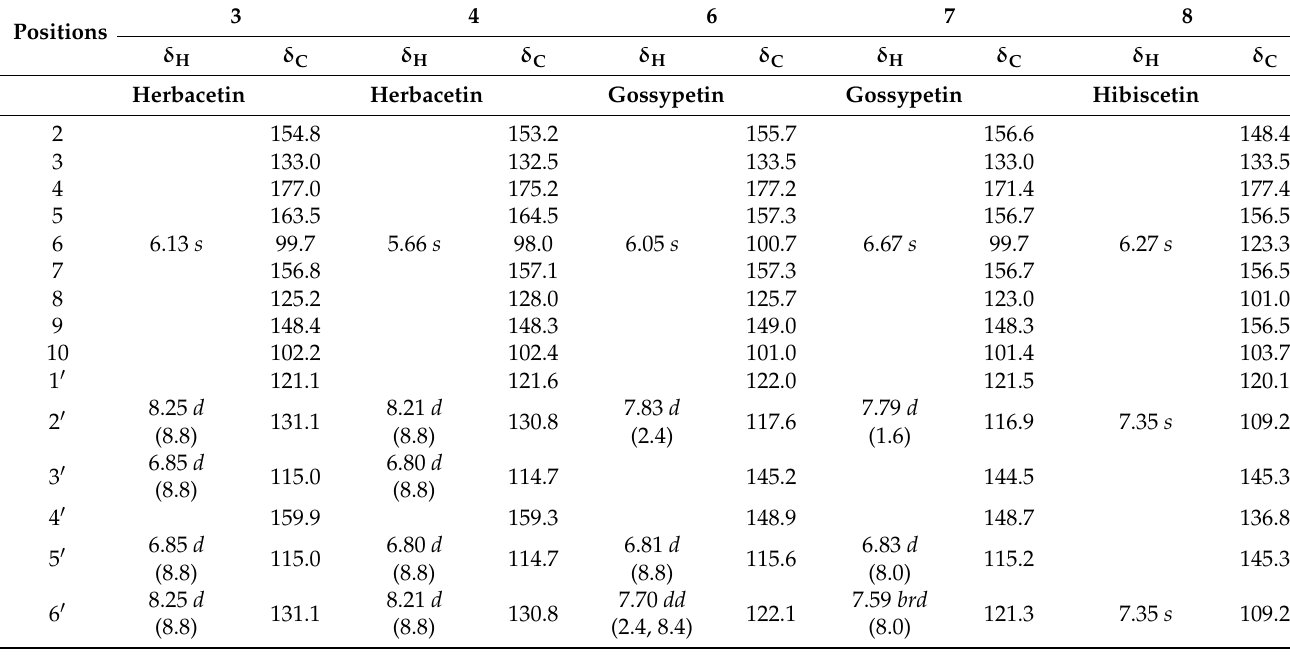
Table 1. 1 H (800 MHz) and 13 C (200 MHz) NMR data (DMSO- d 6 ) of flavonoid glycosides from Sedum japonicum subsp. oryzifolium